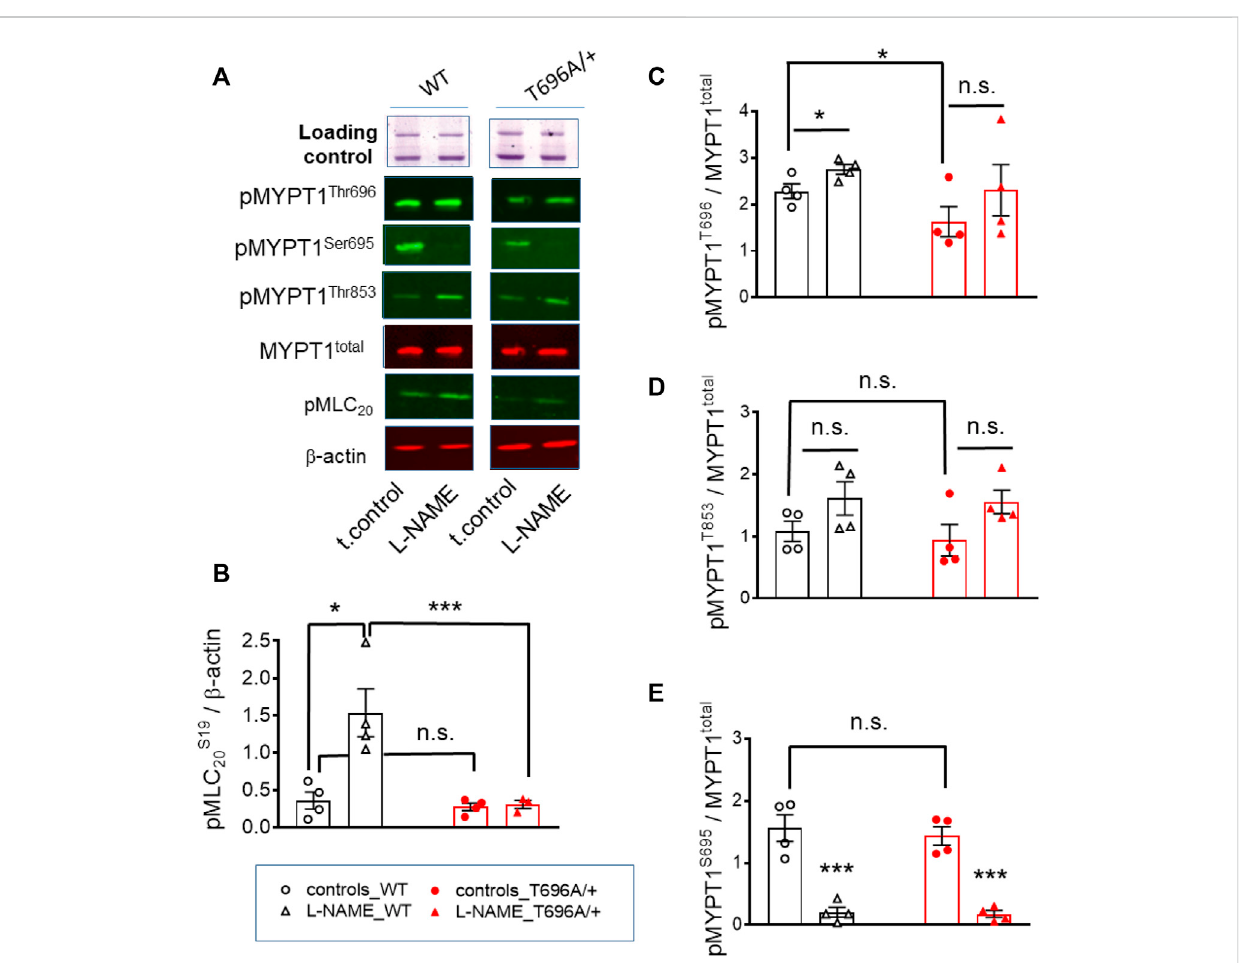
Basal and L-NAME-induced phosphorylation of pMLC 20 -S19, pMYPT1-T696, pMYPT1-T853, pMYPT1-S695 in basilar arteries from young WT and MYPT1-T696A/+ -mice. Original chemiluminograms (A) and statistical evaluation (B – E) of the immunoreactive signals of lysates of y-BAs from WT and MYPT1-T696A/+ mice transferred on nitrocellulose membranes and probed with antibodies against pMLC 20 -S19, pMYPT1-T696, pMYPT1-T853, and pMYPT1-S695.Statistical fi gures representtheratio oftheimmunoreactive signal ofpMLC 20 -S19normalizedto β -Actin orpMYPT1-T696, pMYPT1- T853, and pMYPT1-S695 normalized to MYPT1-total ( n = 4). Arteries were treated using same experimental protocol as in Figure 1. Statistic comparison on (B) represents evaluation using two-way ANOVA (*** p < 0.0001; n = 4). *** p < 0.0001, * p < 0.05 represents evaluation by unpaired t -tes t ( n = 4). n.s. — not signi fi